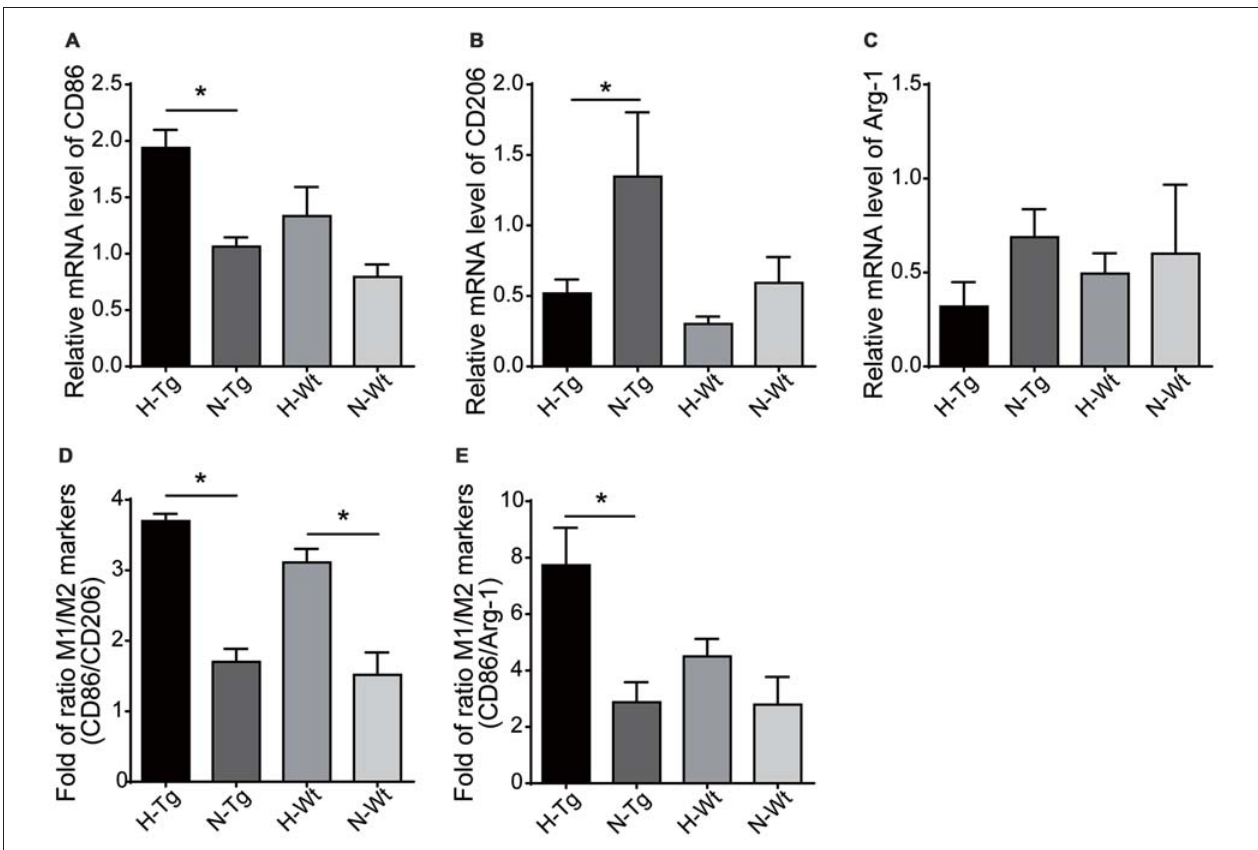
FIGURE 5 | mRNA levels of M1 and M2 markers were evaluated by real-time polymerase chain reaction (PCR). M1 marker, CD86, increased in H-Tg group (A) and M2 markers, CD206 and arginase-1 (Arg-1), decreased in hypoxia groups (B,C) . The ratio of CD86/CD206 (D) and CD86/Arg-1 (E) increased significantly in hypoxia groups, n = 4 in each group. Data were the mean ± SEM values. ∗ p < 0.05 by one-way